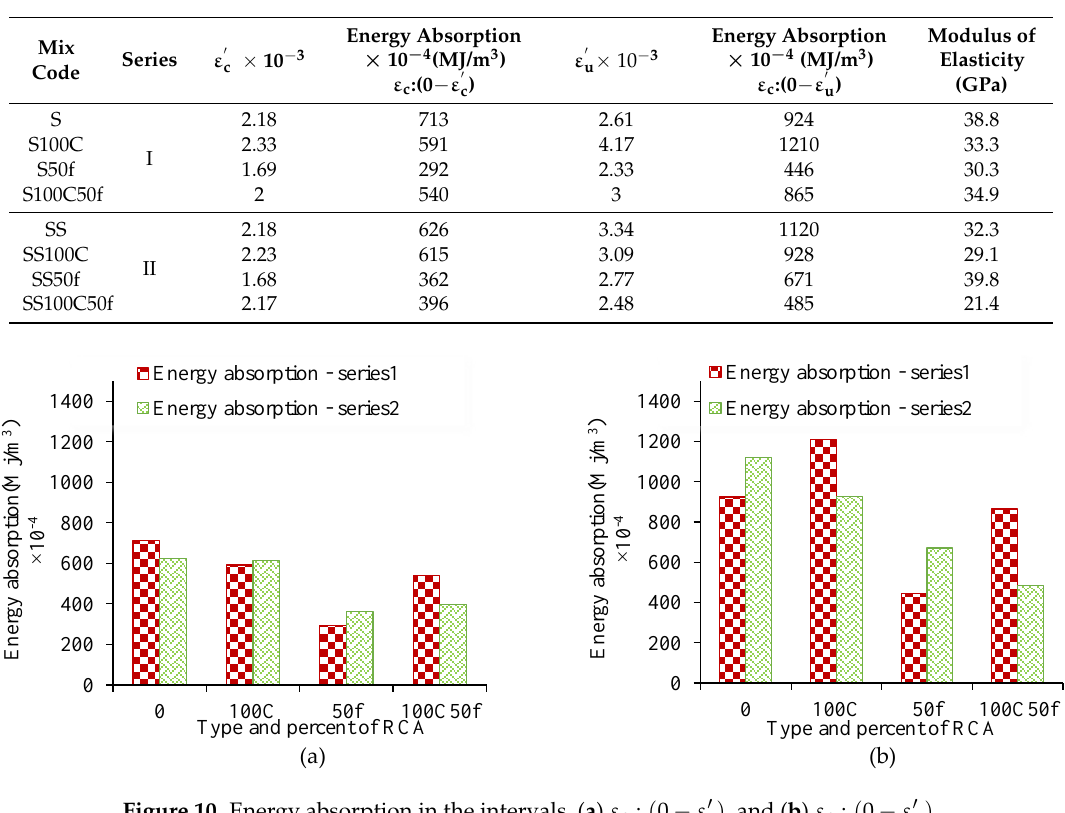
Figure 10. Energy absorption in the intervals, ( a ) ε c : (0 − ε c′ ) , and ( b ) ε c : (0 − ε u′ ) .